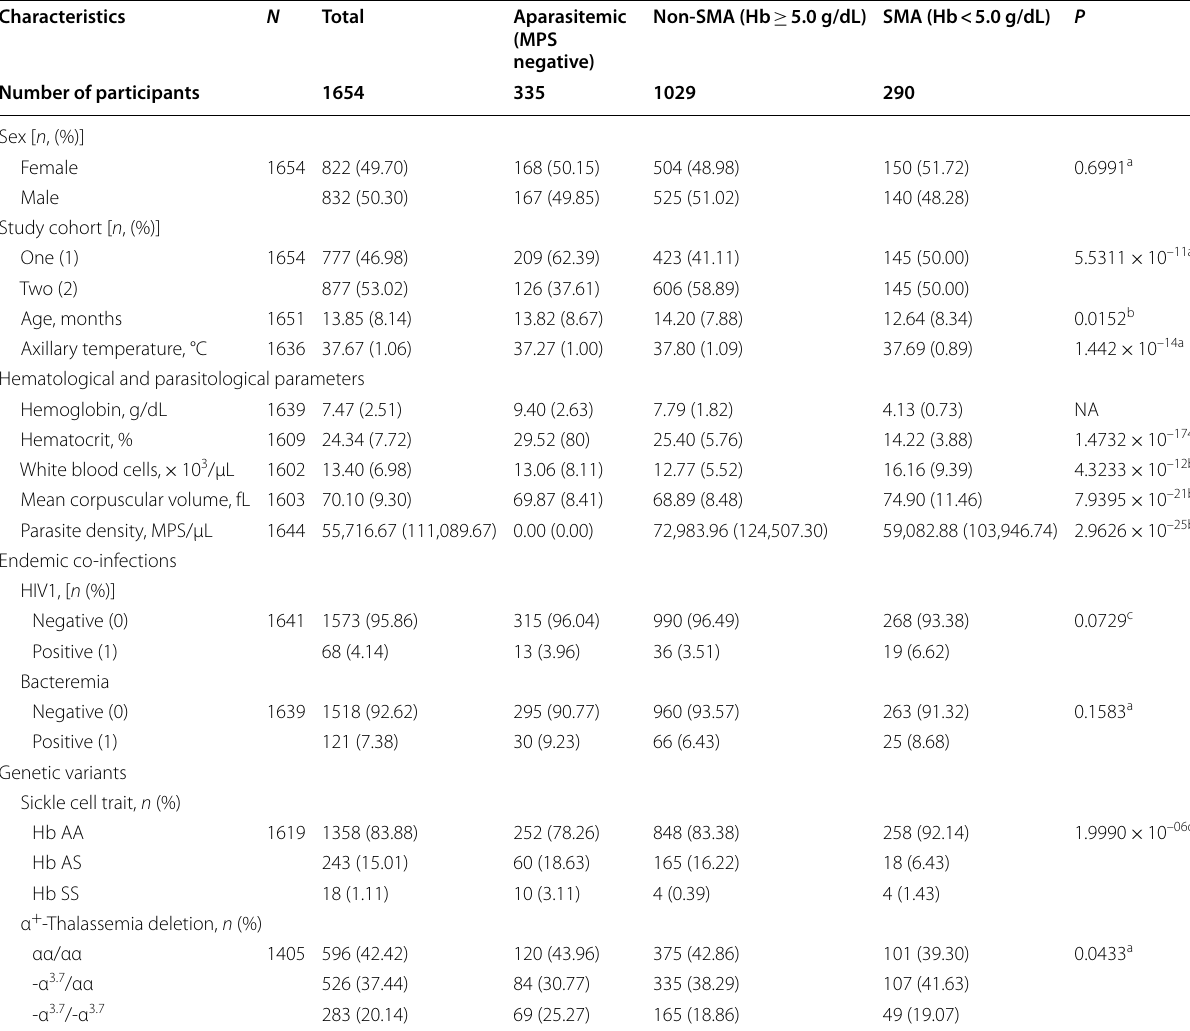
Table 1 Demographic, clinical, and laboratory characteristics of the study participants